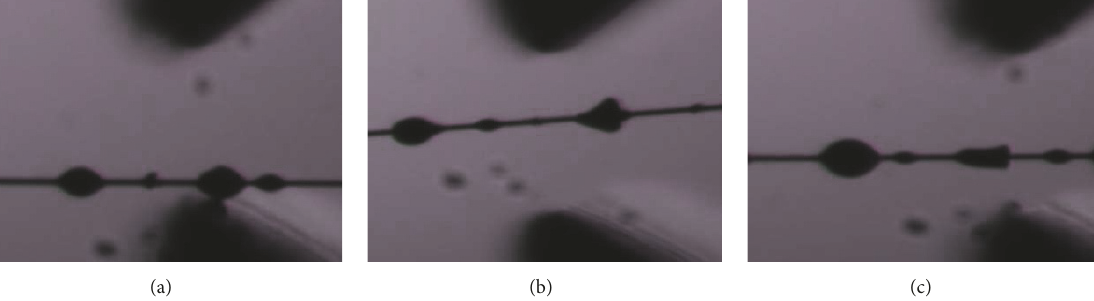
Figure 9: The process of fiber outperformed at different temperatures: (a) temperature < 𝑇 𝑔 ; (b) temperature near to 𝑇 𝑔 ; and (c) temperature > 𝑇 𝑔 .